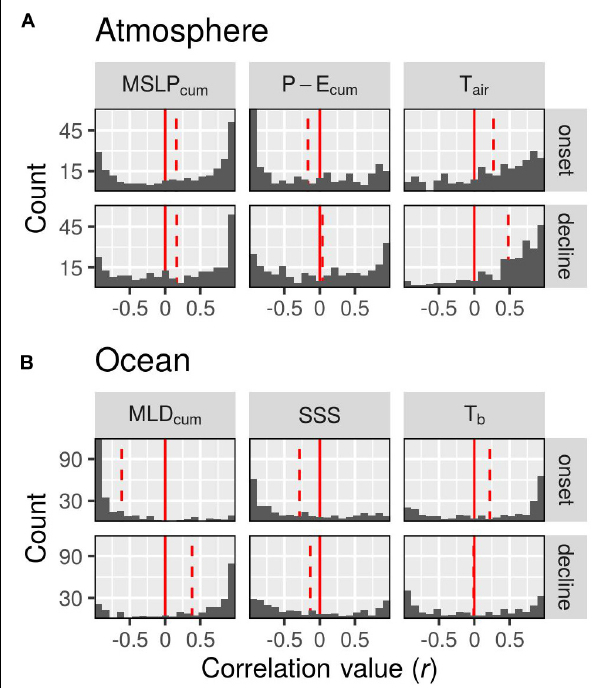
FIGURE 4 | Histograms of correlation values ( r ) between SSTa and several important candidate forcing variables, shown separately for the onset and decline of marine heatwaves (MHWs). The solid vertical red line on the x -axis shows r = 0, meaning no correlation. The dashed vertical red line shows the mean value in the histogram. Panel (A) contains the results for the top three atmospheric variables, and (B) contains the results for the top three oceanic variables. Note the difference in the y -axes. The variable abbreviations may be found in Sections “Data” and “Agreement